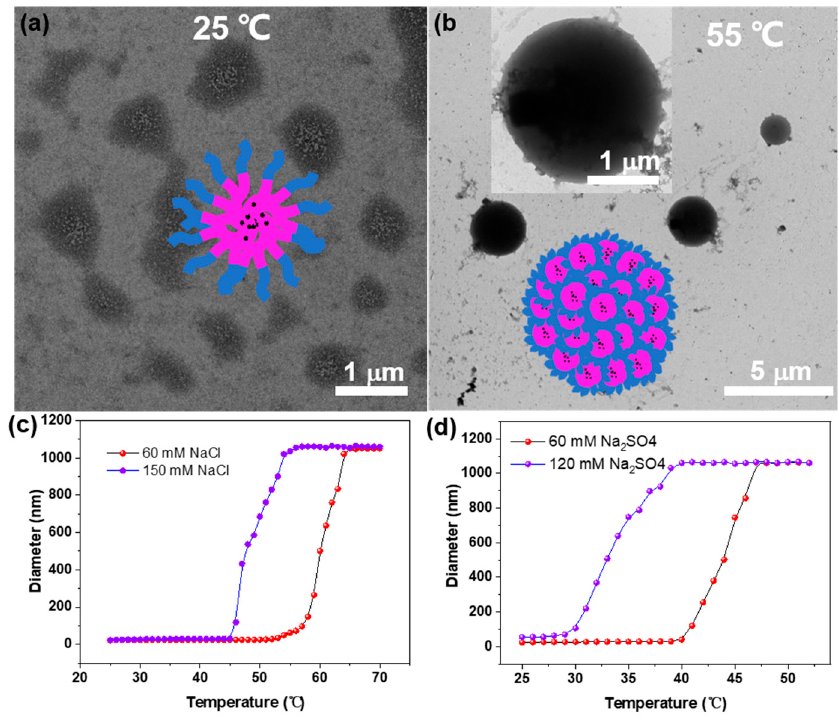
Figure 3. TEM images of the P2 at ( a ) 25 °C and ( b ) 55 °C with 500 mM NaCl. The diameter variation of P2 upon the temperature increases with different concentrations of ( c ) NaCl and ( d ) Na 2 SO 4 .